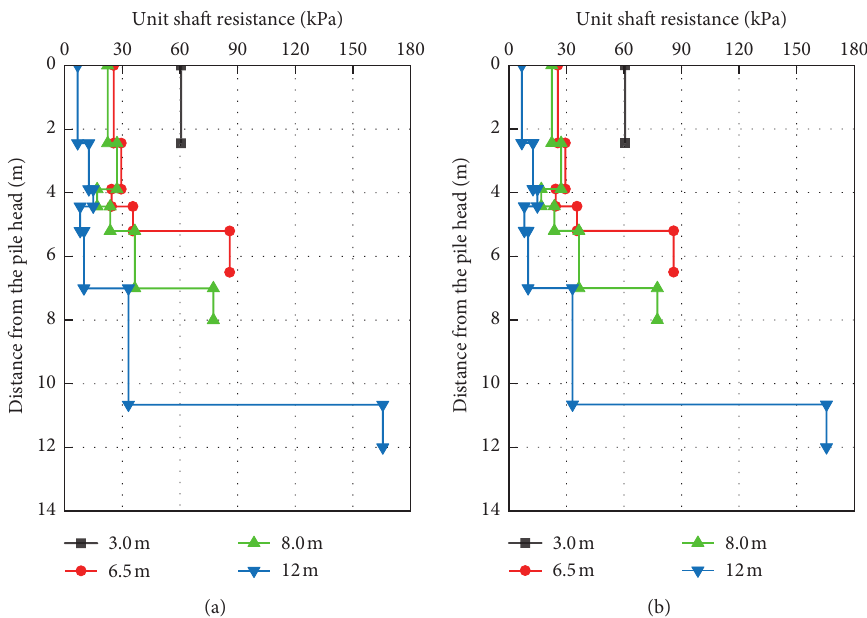
Figure 7: Unit shaft resistance along piles at different penetration depths: unit shaft resistances of (a) P1 and (b)